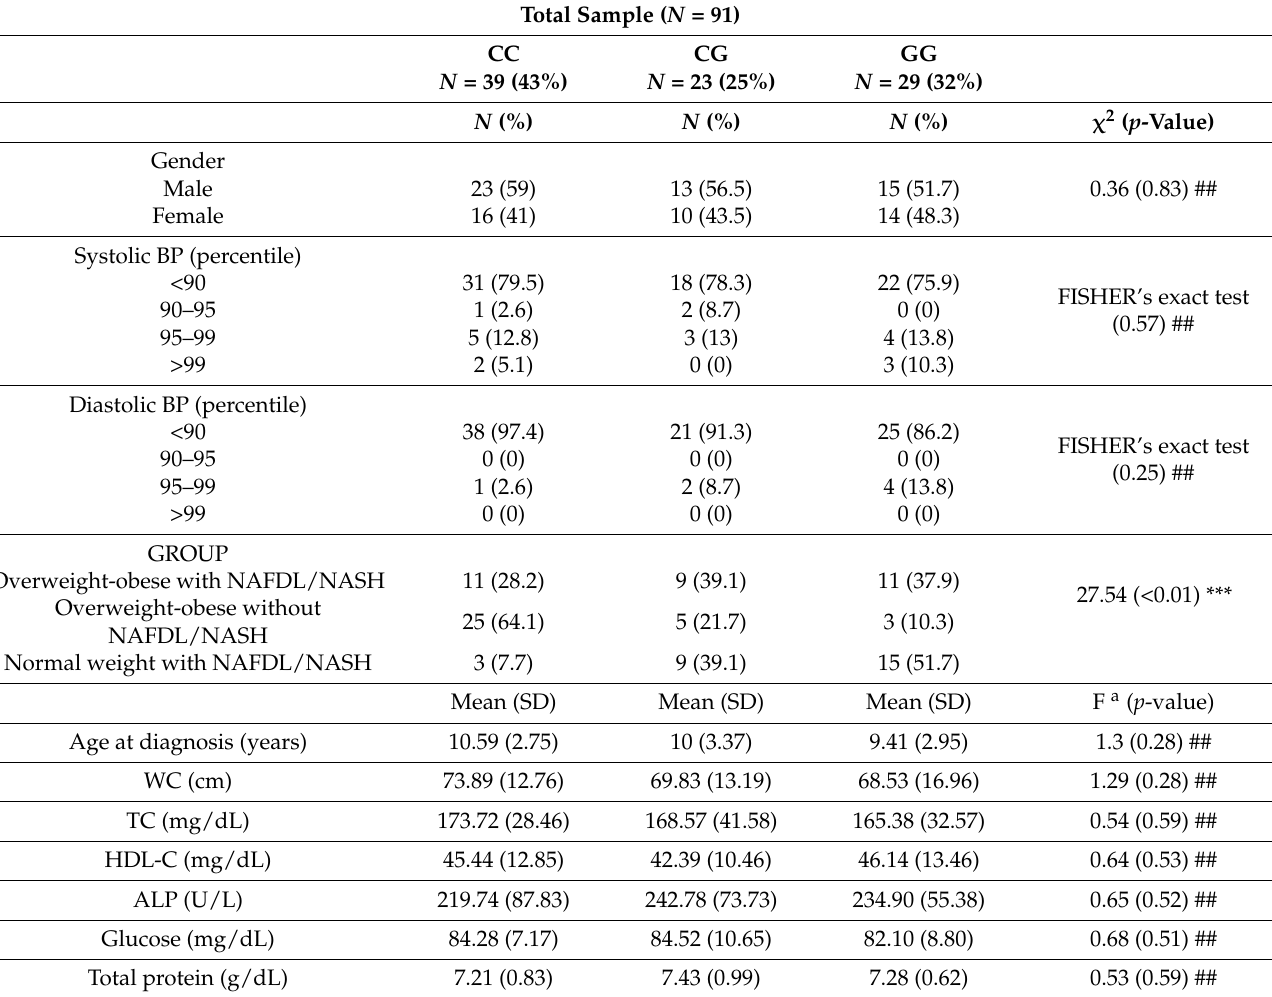
Table 3. Demographic, basic clinical, and laboratory characteristics by genotype of